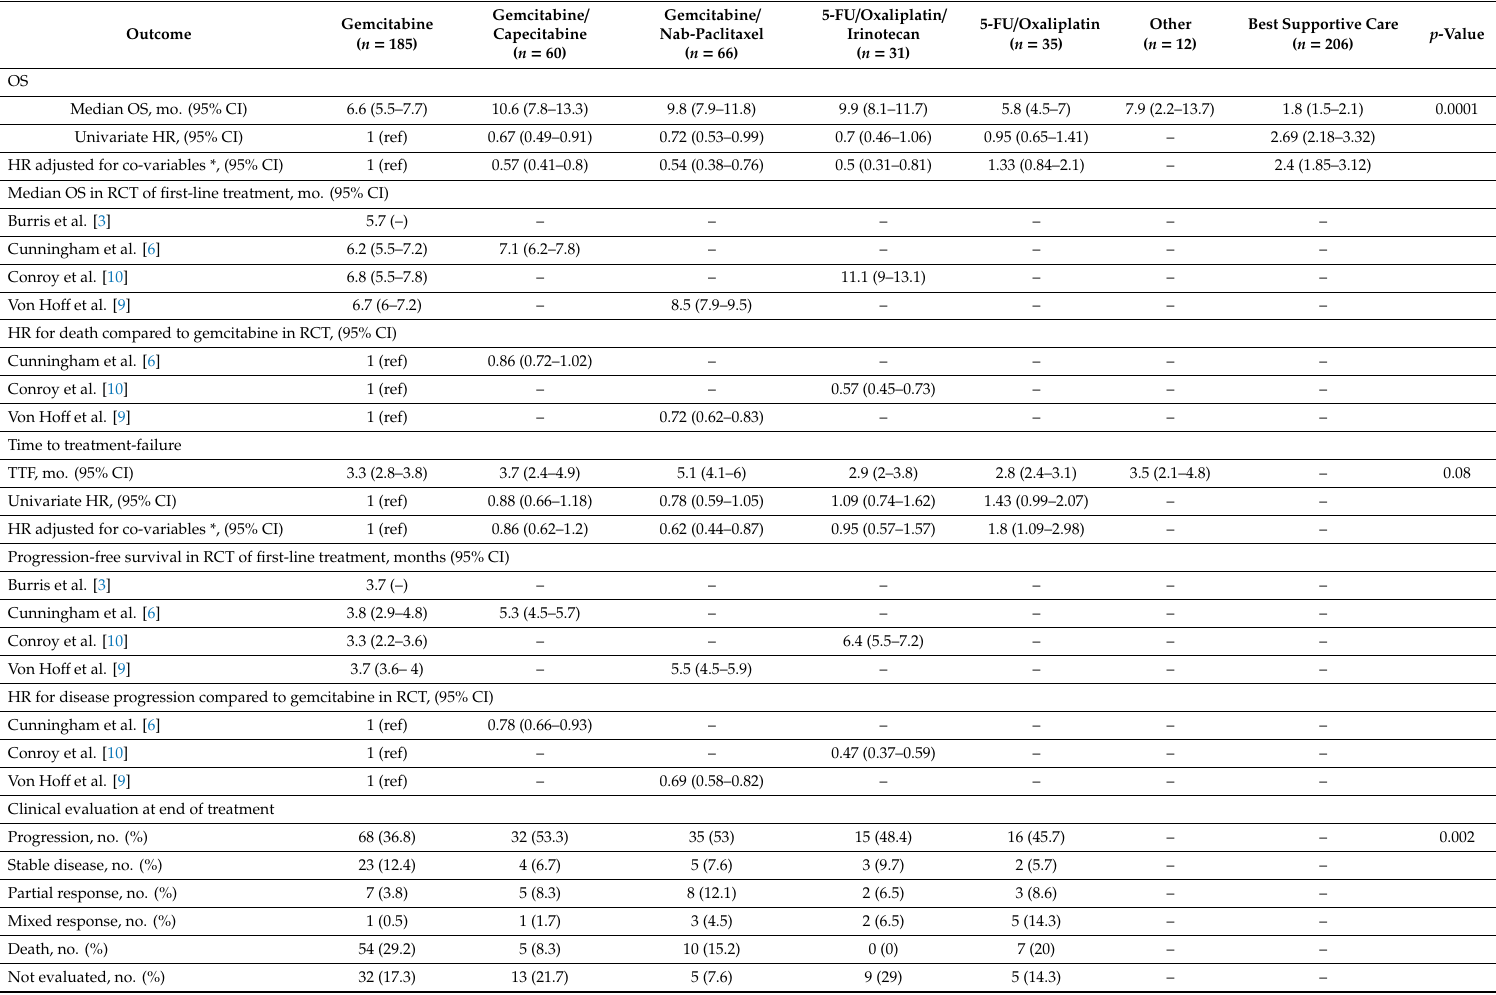
Table 2. Overall survival (OS), hazard ratios (HRs) for death, and treatment failure according to first-line regimen.